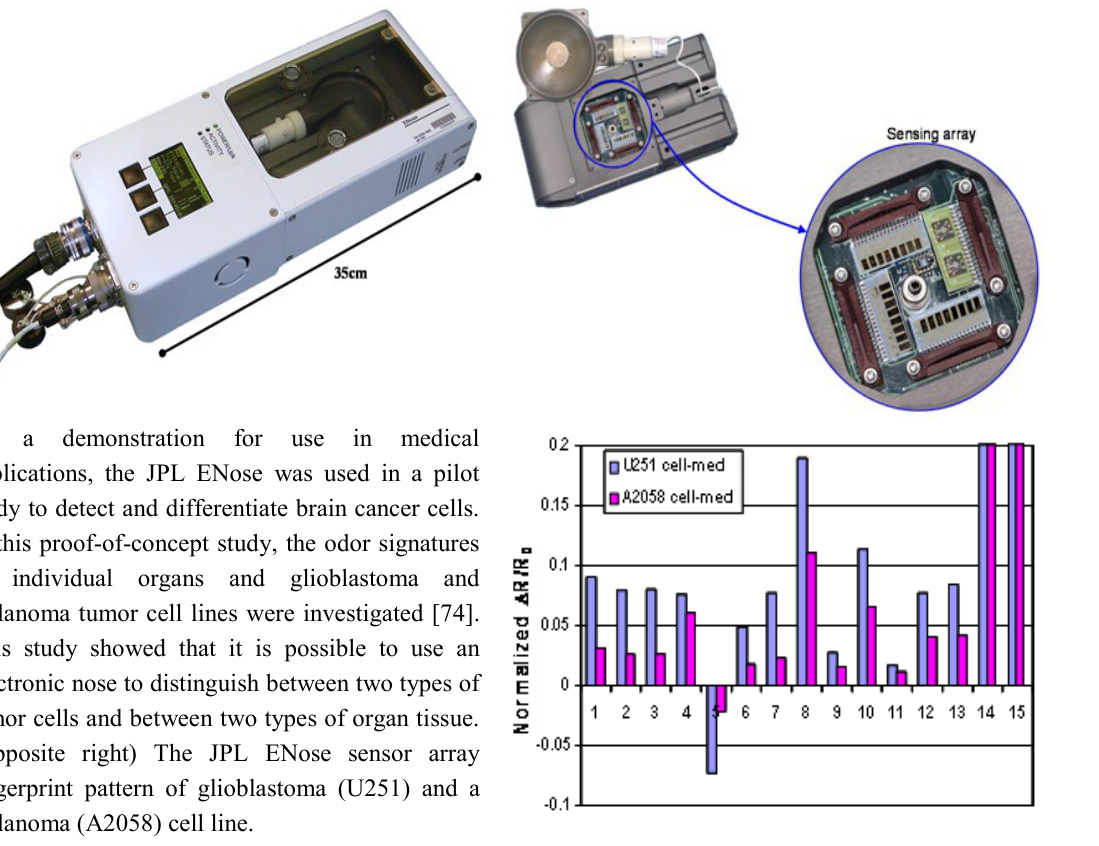
Figure 7. Chemoresistive Sensor Array. The JPL Electronic Nose (ENose: below left) [71,72] is an event monitor designed and built for near real time air quality monitoring in crew habitats aboard the space shuttle/space station. This is an array-based sensing system which is portable (low volume and power), and designed to run continuously and autonomously. The sensor array is optimized to monitor (detect, identify, and quantify) for the presence of selected chemical species in the air at parts-per-million (ppm) to parts-per- billion (ppb) concentration ranges. For each sensor (below right), resistance is recorded, the change in resistance is computed against a background, and the distributed response pattern (fingerprint or smellprint) of the sensor array is used to identify gases and mixtures of gases